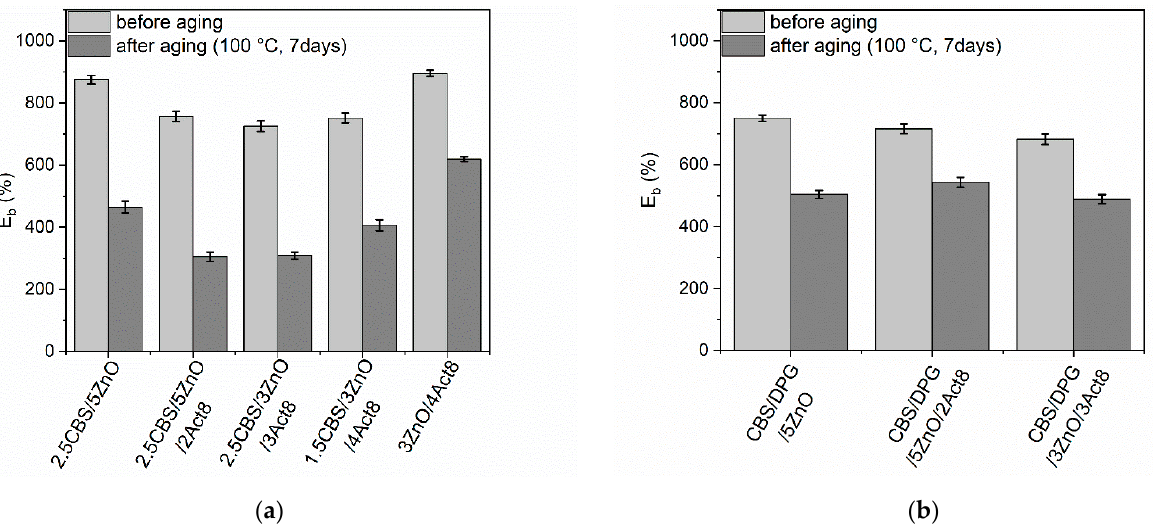
Figure 8. Influence of thermo-oxidative aging on the elongation at break (E b ) of SBR vulcanizates containing: ( a ) CBS; ( b ) CBS and DPG.